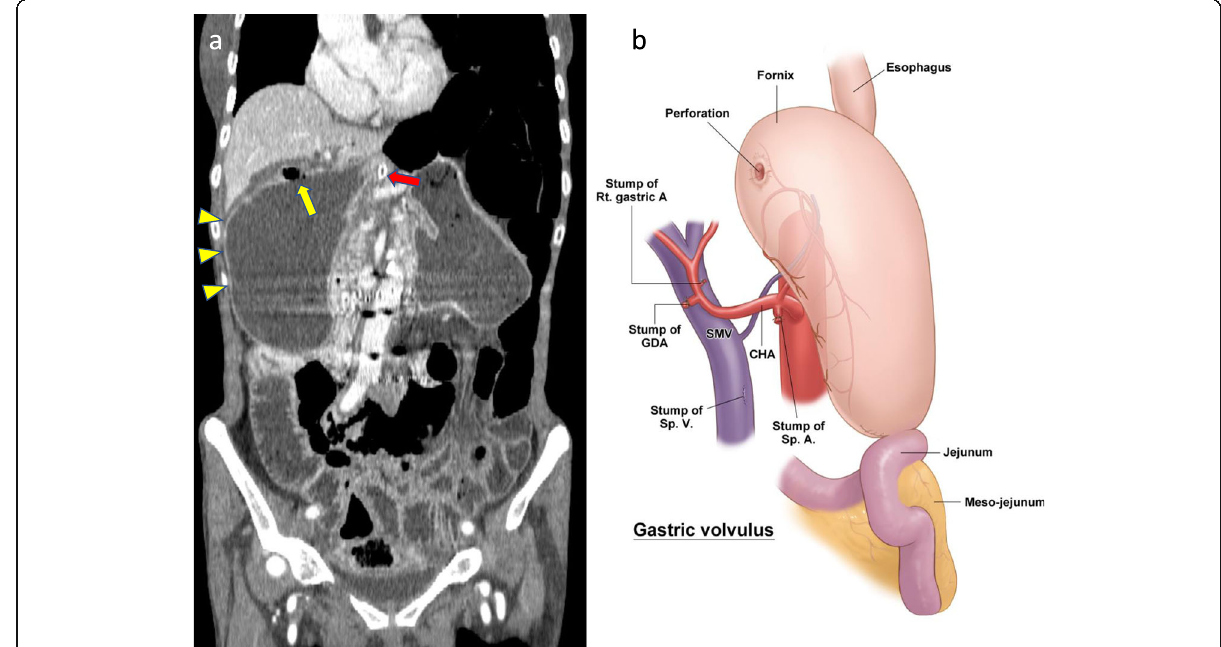
Fig. 2 CT image and schema. a An organo-axial gastric volvulus and free air (yellow arrow) can be observed (coronal view). b Schema of gastric volvulus with perforation. Red arrows: naso-gastric tube, arrowheads: fornix of the stomach. rt. gastric A., right gastric artery; GDA, gastroduodenal artery; SMV, supramesenteric vein; CHA, common hepatic artery; Sp. A., splenic artery; Sp. V., splenic